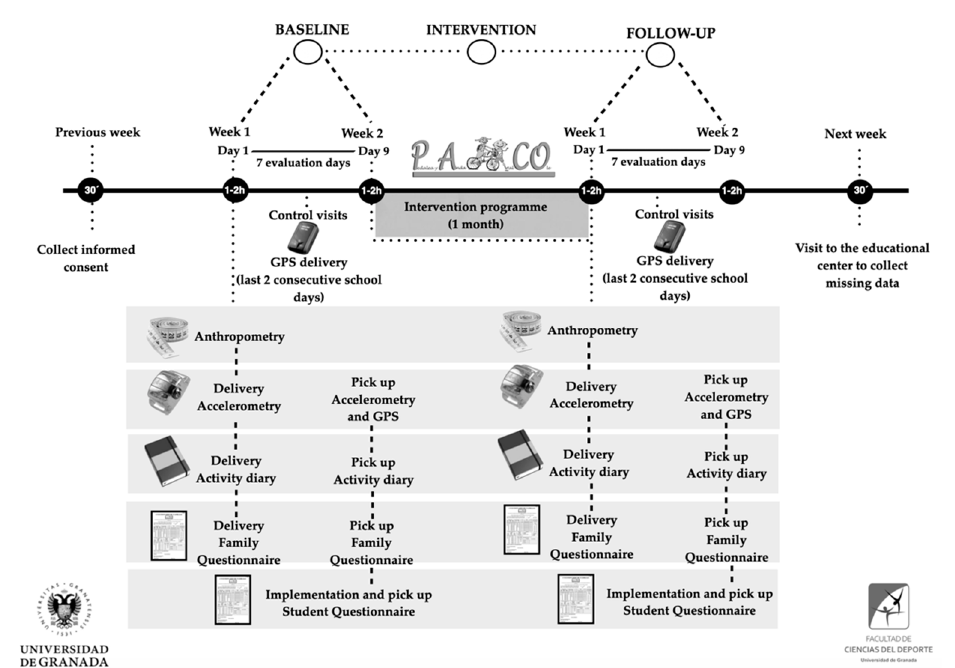
Figure 5. The measurement procedure of the PACO study.